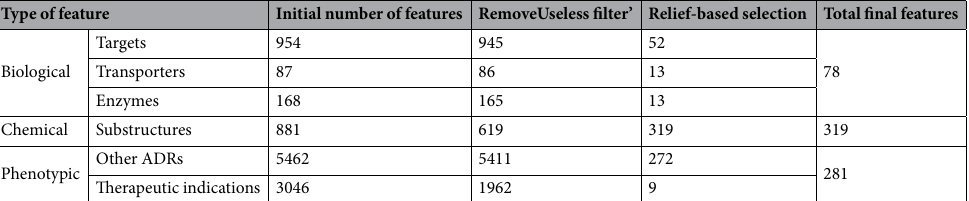
Table 1. Lists the number of features obtained after applying RemoveUseless filter and relief-based feature selection and types of features used to generate the models.